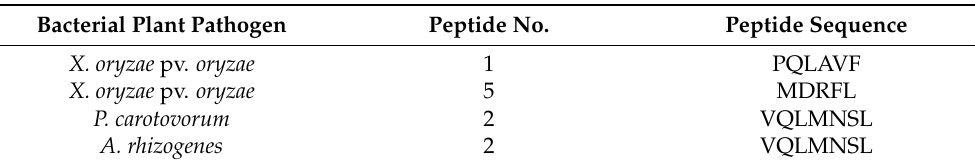
Table 6. Selected peptides and bacterial plant pathogens used for the determination of antibacterial mechanisms by shotgun proteomics.